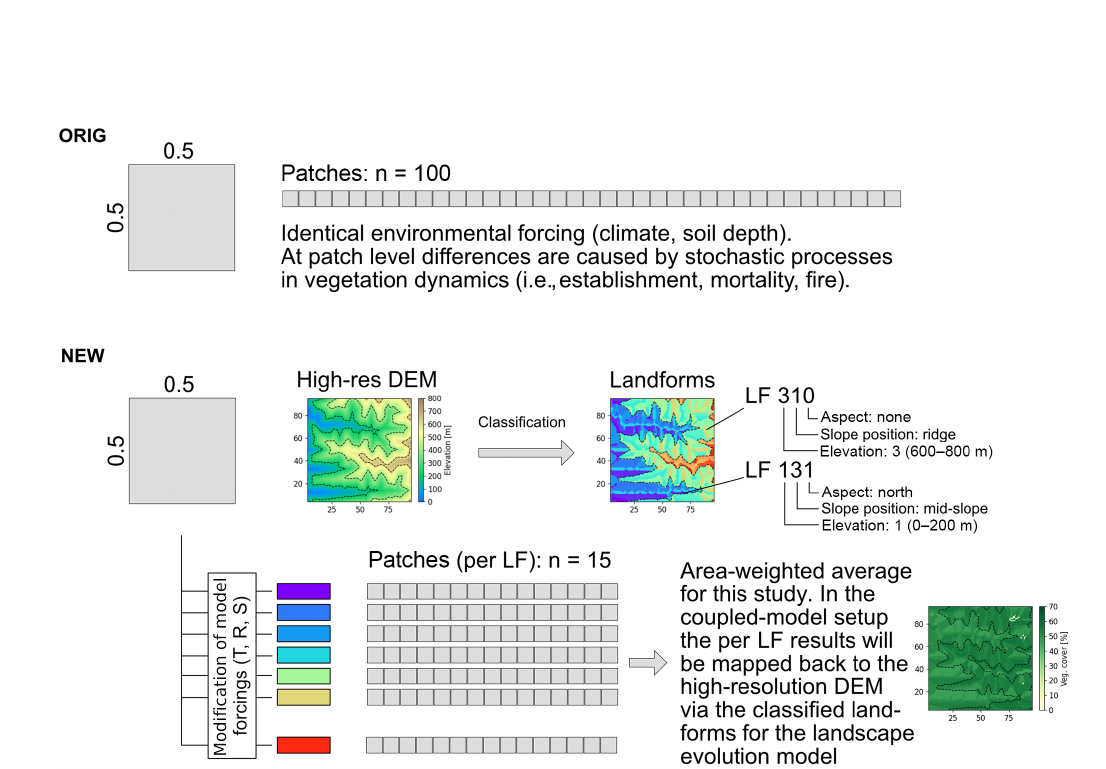
Figure B1. Conceptual difference between original LPJ-GUESS patch setup and the new landform addition ( T is temperature, R is radiation, S is soil depth, and LF is